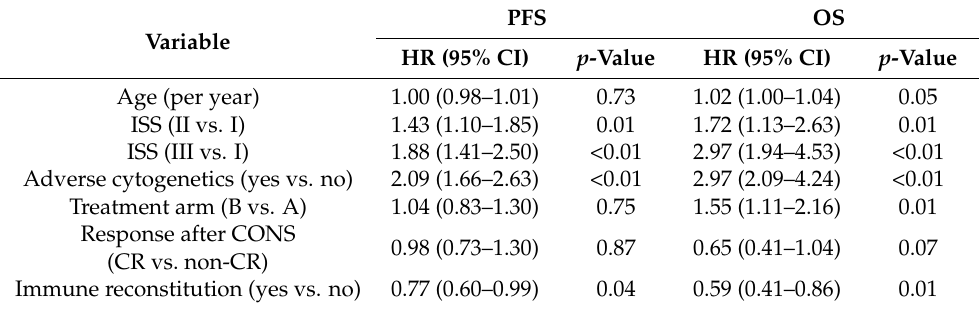
Table 3. The impact of achieved immune reconstitution until the start of maintenance at the latest on PFS and OS. The results of the time-dependent multivariate Cox regression analysis.